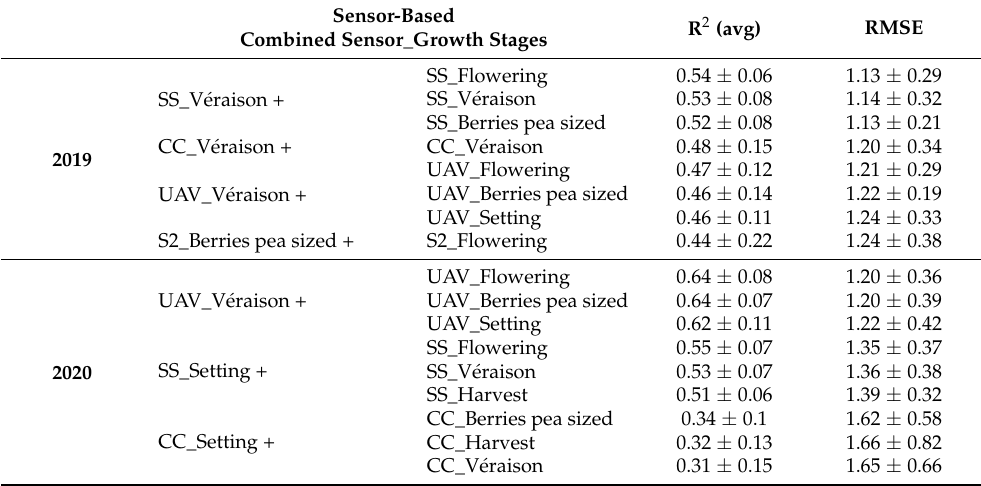
Table 4. Selected best performed sensor-based R 2 per year for combined sensors and growth stages using AutoML to evaluate their performance in assessing the wine grapes quality characteristics (legend as for Table 2).